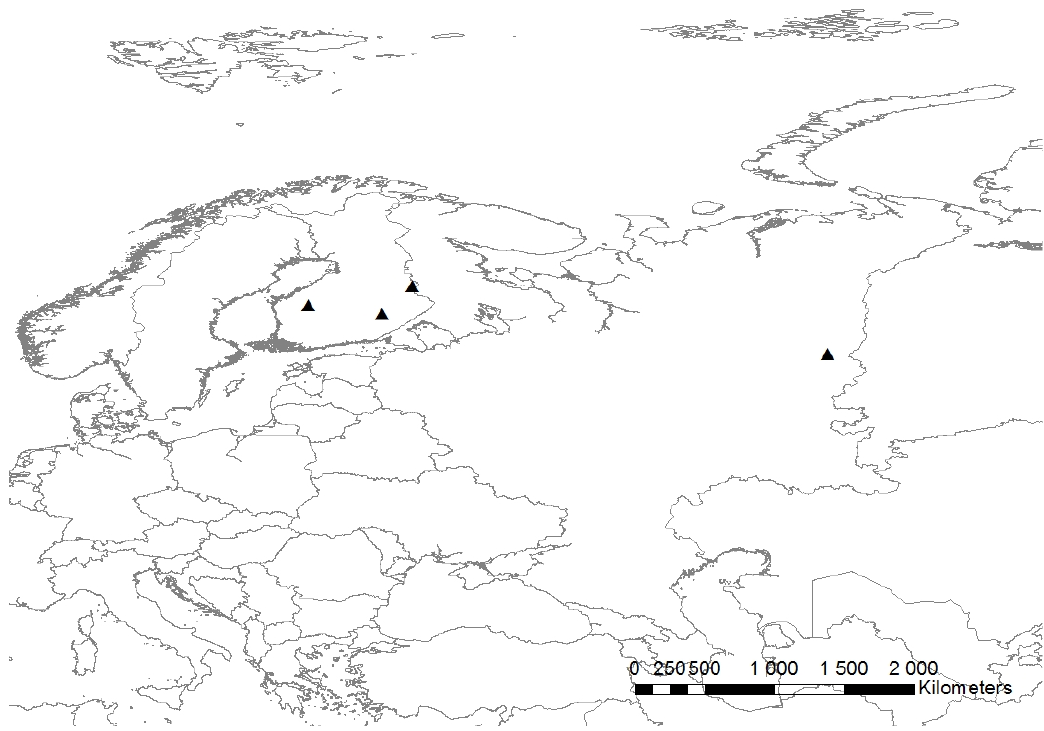
Figure 1. Location of the Perm study site and the Finnish study sites marked with black triangles. Background map data source and copyright DeLorme/Garmin Ltd. and Esri.